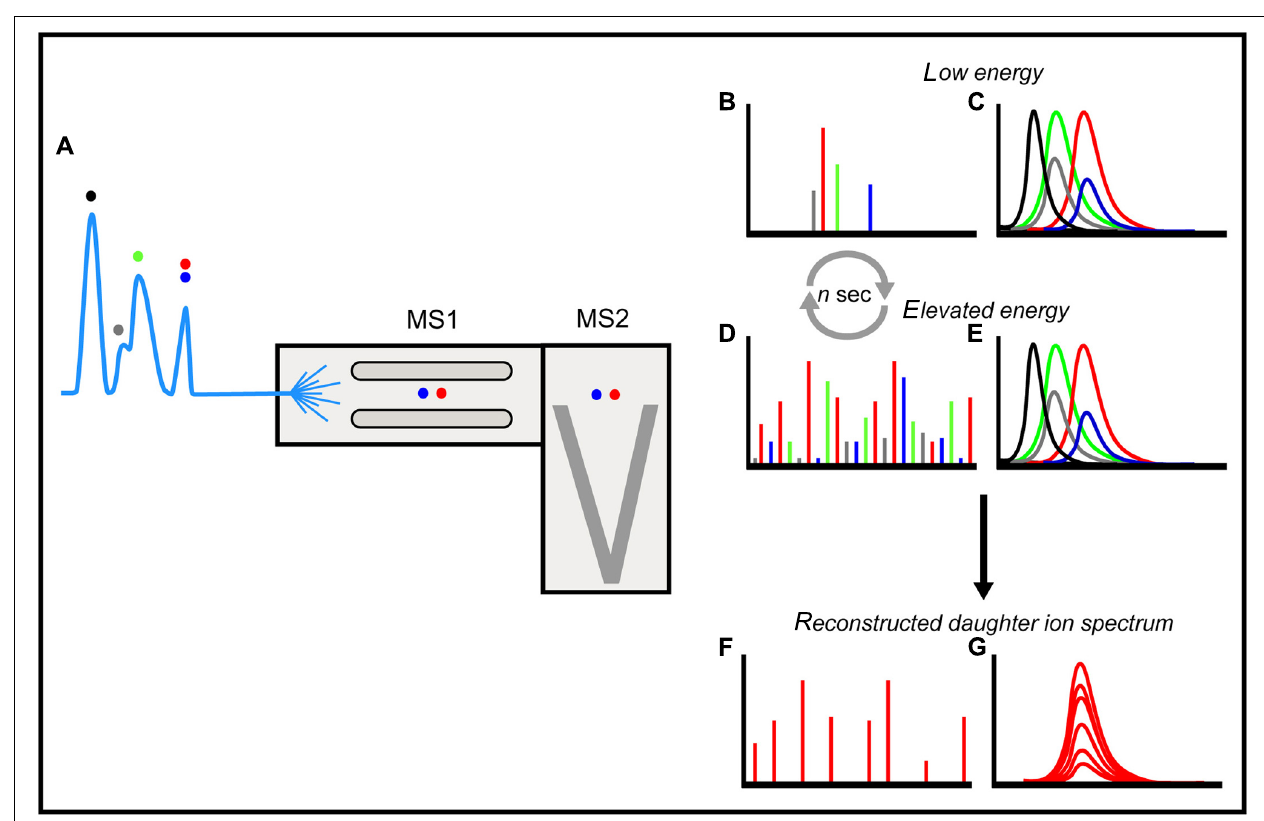
only, an ion-accounting algorithm compares the retention time profiles of all individual parent ions (C) to all individual daughter ions (E) matching them on the basis of retention time profile and intensity (G) . In this manner the algorithm creates a reconstructed daughter ion spectrum matched to a single precursor (F) that can be used by proteome search engines to identify peptides and link these to proteins.The unbiased data-independent scanning mode greatly expands the number of peptides – and thus of proteins – detected, compared to the DDA mode of acquisition on QTOF type instruments, especially using limited LC separations on complex mixtures to increase throughput. Adapted from (Plumb etal.,